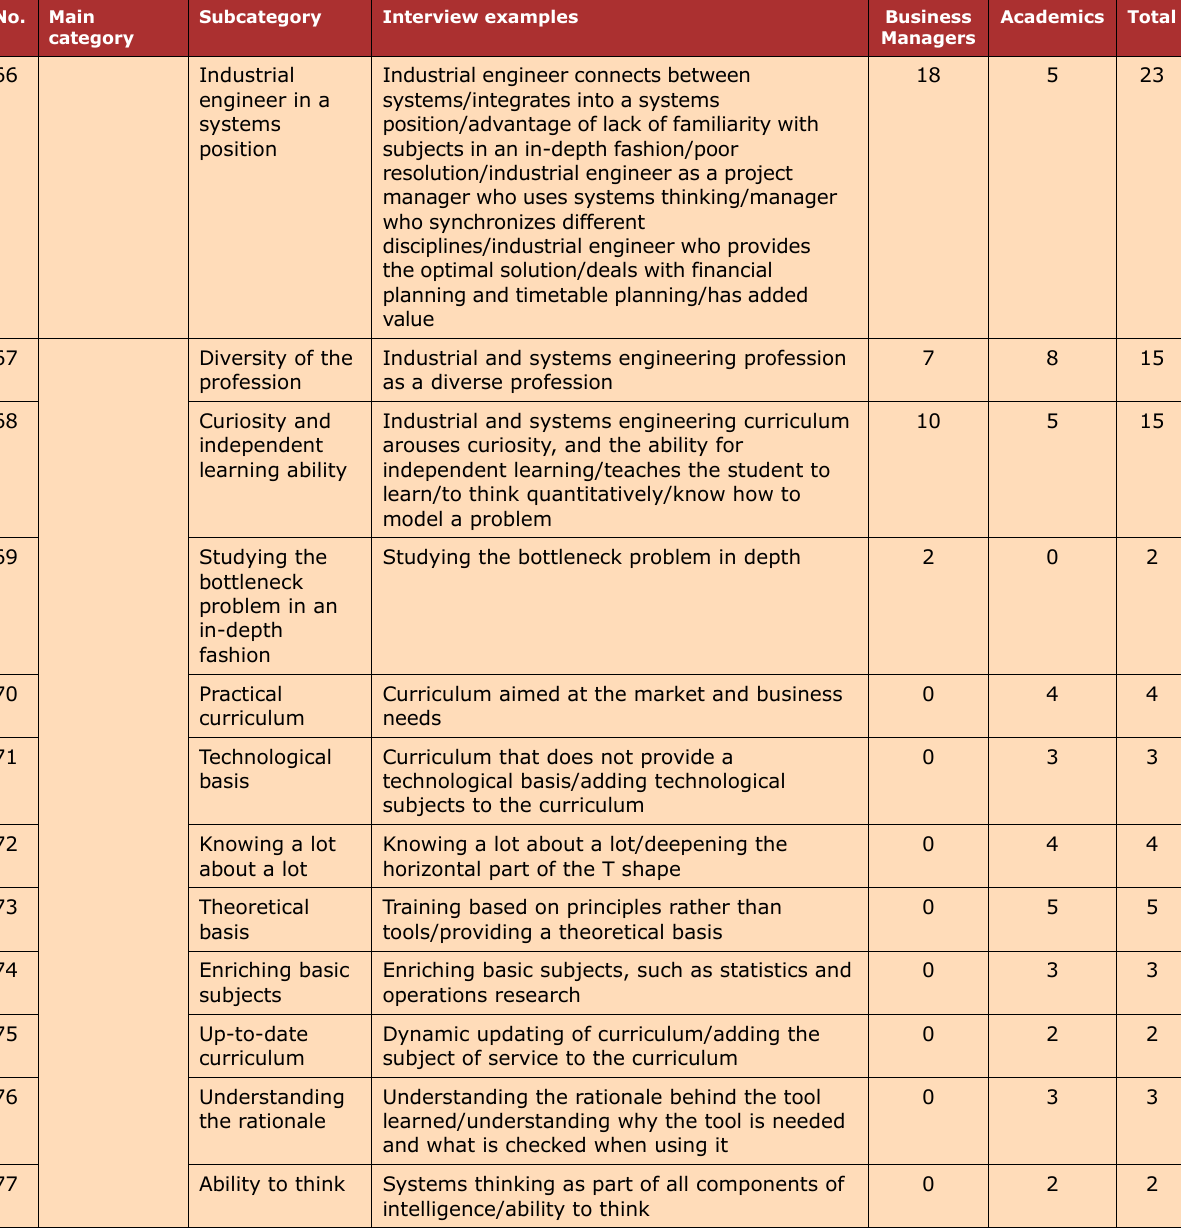
Table 1A. Summary of interview categories regarding the T-shape dilemma